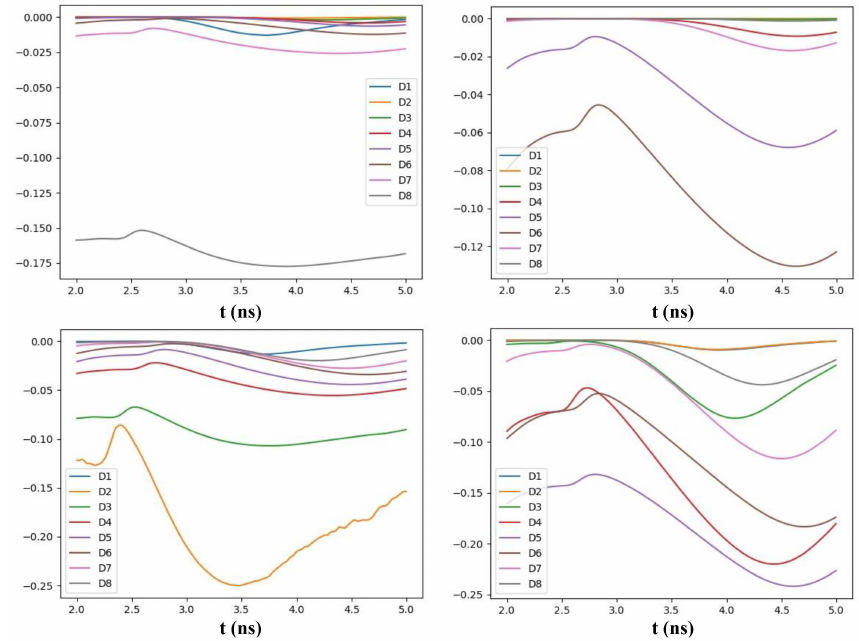
Figure 2. Temporal profiles of absorption measure A = I abs ( t ) / I noabs ( t ) − 1 on 8 detectors (D1–D8). The horizontal axis is time in units of nanoseconds (ns). The upper left panel shows the profiles for an absorber located at the #3 position, upper right panel for an absorber at #26 position, lower left panel for an absorber at #0 position, and lower right panel for an absorber at the #13